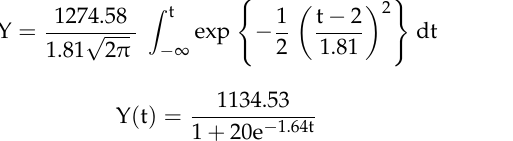
Table 2. Both the Kleczkowski model [54,56] and the growth curve model [49,54] were fitted to the local lesion number induced by ToBRFV-suspensions with virus concentrations of 128 ng/mL up to 2 mg/mL with the least χ 2 error, meaning a very good fit (Table 2). i Both models fitted best with transformed means of the number of local lesions observed for inoculation of highest and middle concentrations of ToBRFV particles (i.e., 2, 0.016, and 0.0032 mg/mL) (Table 2). However, at the lowest concentration (i.e., 128